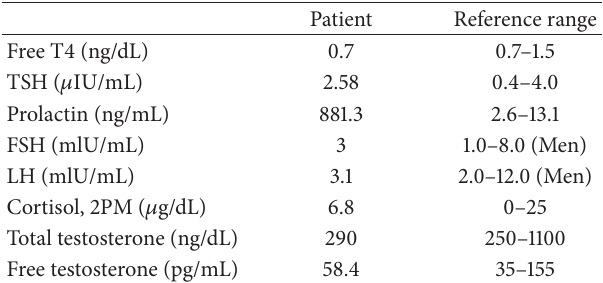
Table 1: Patient’s endocrinological lab